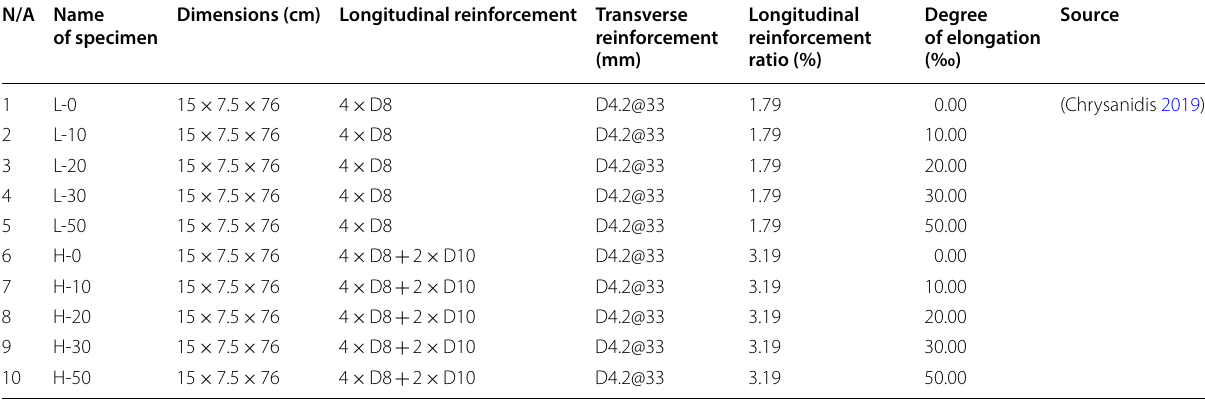
Table 7 Summary of test data for columns found in the international